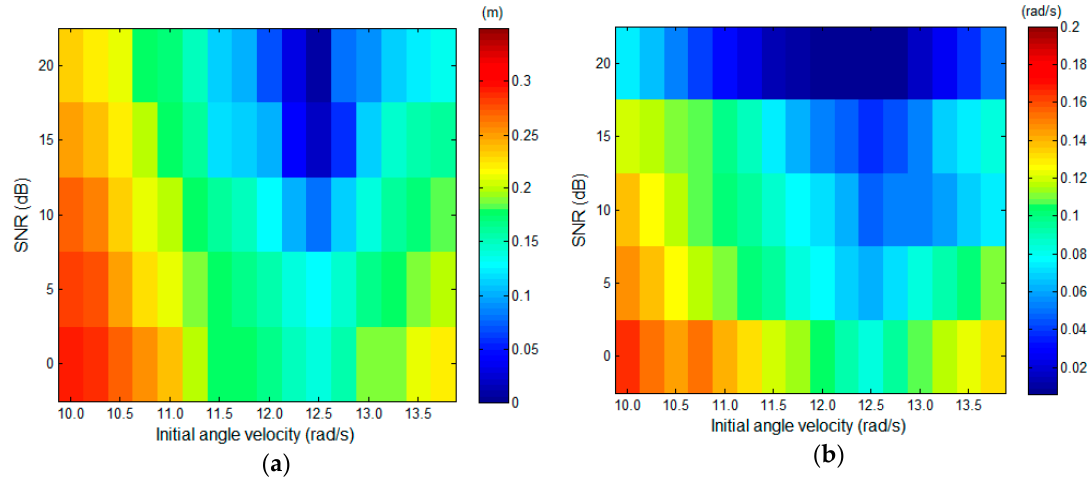
Figure 11 . RMSEs of 3D reconstruction and angular velocity estimation. ( a ) RMSE of the 3D reconstruction against different initial angular velocity and SNR; ( b ) RMSE of the angular velocity estimate against different initial angular velocity and SNR.